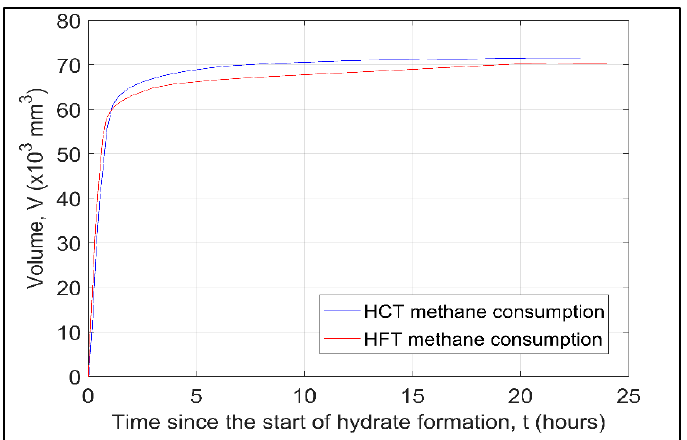
Figure 9. Comparison of methane gas consumption for HCT and HFT during the hydrate formation period (24 h). period (24